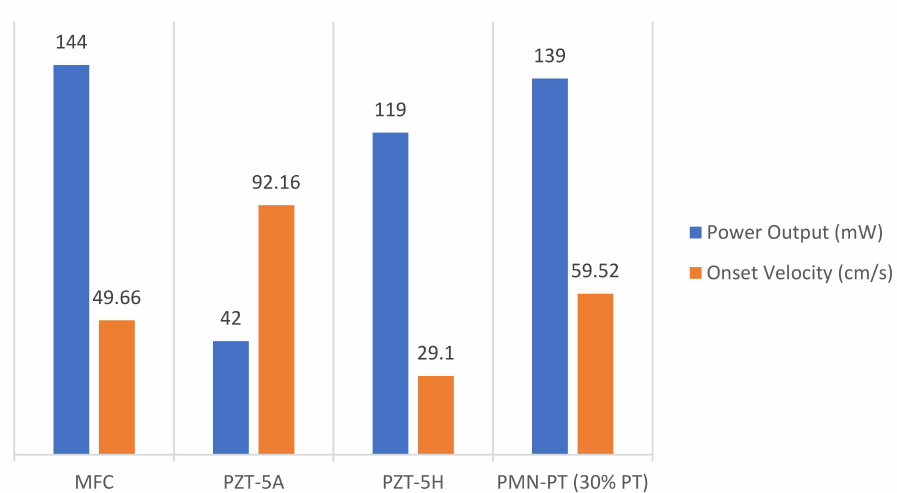
Figure 15. Power Output and Onset Velocity for Different Piezoelectric Materials at the Opti- mal Model.